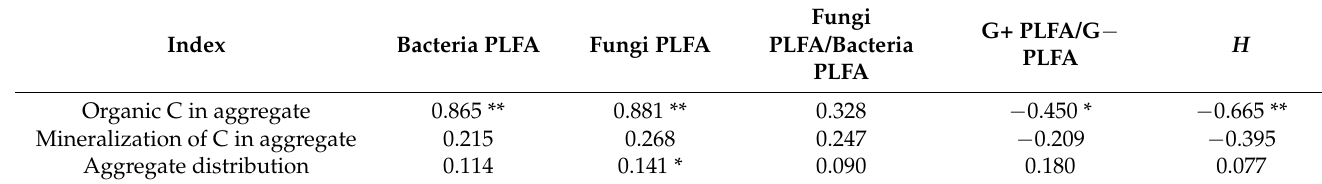
Table 4. Relationships between mineralization of organic C and microbial